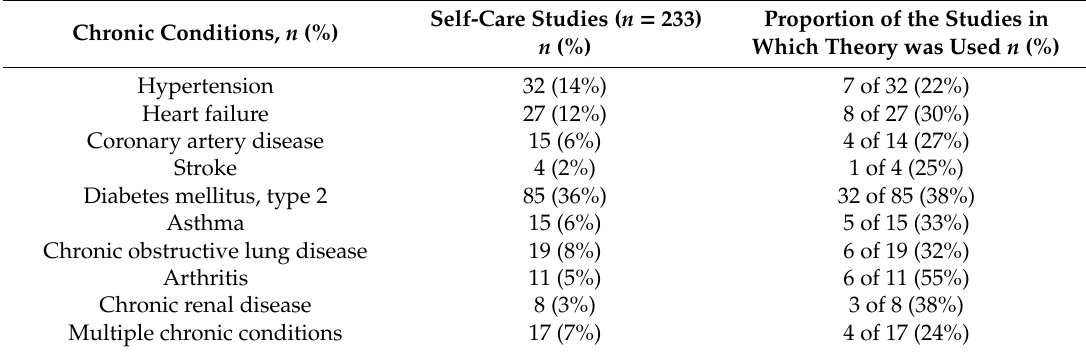
Table 1. Use of theories in self-care research for patients with a chronic condition ( n = 233).